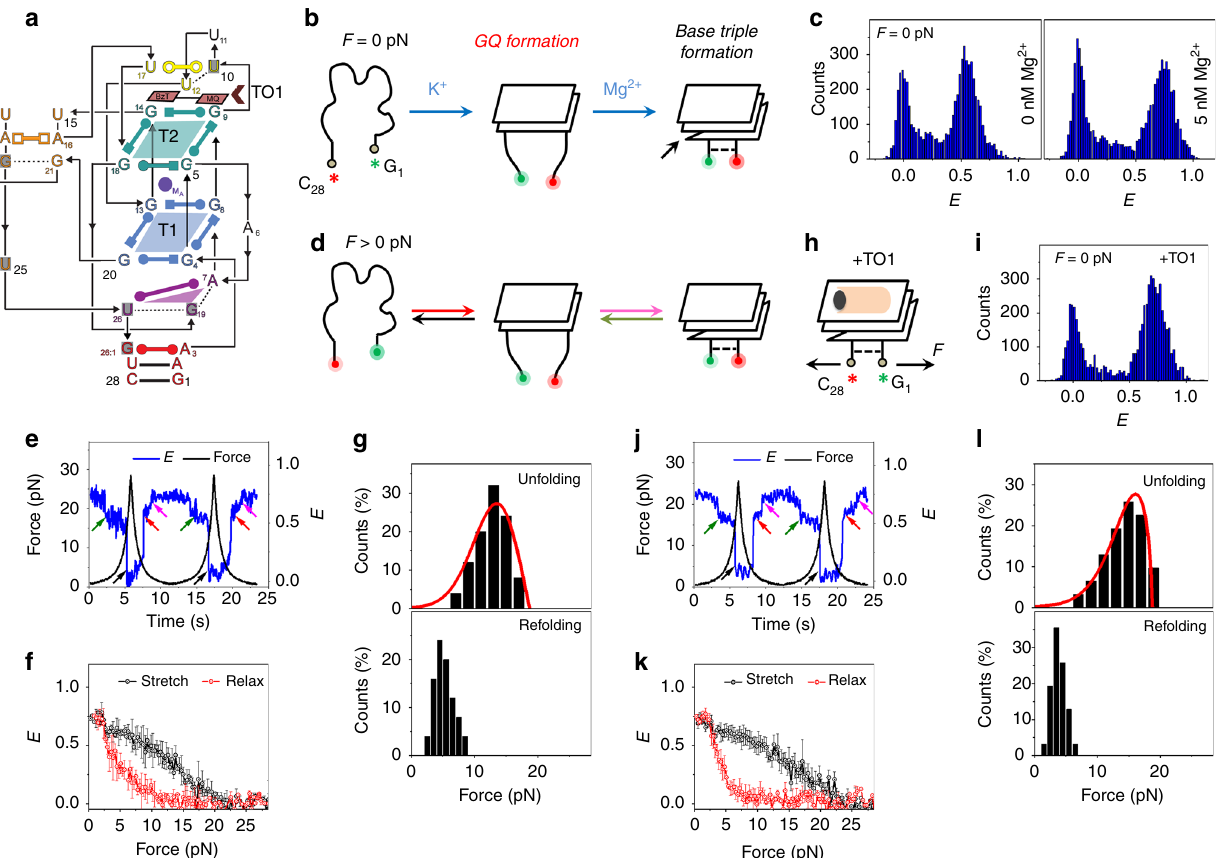
Fig. 3 Conformational dynamics of i MangoIII. a Sequence and secondary structure of i MangoIII used in this study. T1 and T2 denote the G-quartets in i MangoIII. TO1 is indicated by the brown arrowhead 51 . Adapted with permission from ref. 51 . b Schematic of probable sequential folding of i MangoIII GQ and the fl anking base triple, in the absence of force. The structures are drawn with reference to the recently solved crystal structure 51 . The Cy5 and Cy3 dyes adjacent to C 28 and G 1 are shown as red and green asterisks, respectively. c E histograms of i MangoIII in a buffer containing 100 mM K + , with (right) and without (left) Mg 2 + , in the absence of force. d Schematic of unfolding (green and black) and refolding (red and magenta) transitions of i MangoIII, under an applied force. Green and magenta arrows respectively indicate unfolding and refolding of the base triple. Black and red arrows indicate unfolding and refolding of the GQ core, respectively. e A representative smFRET time trajectory over two pulling cycles. Unfolding and refolding transitions at ~2.5 pN are indicated by green (stretch) and magenta (relax) arrows. The major unfolding and refolding transitions are shown via black and red arrows, respectively. f Average E vs force response. g Distributions of unfolding and refolding forces corresponding to the black and red arrows in d . ( N = 62 for both). The red curves represent force distributions estimated from the Dudko – Szabo model 46,47 (top). h A schematic of TO1- i MangoIII complex under tension. TO1 is represented by the orange and black symbol. Force ( F ) applied on the construct is shown by arrows. i E histogram of i MangoIII under saturated concentrations of TO1, in the absence of force. j A representative smFRET time trajectory of i MangoIII in the presence of TO1. The arrow indicators used are similar to e . k Average E vs force response in TO1 containing buffer. l Distributions of unfolding and refolding forces corresponding to the black and red transitions in i and fi ts (red curves) predicted from models proposed by Dudko et al. 46,47 ( N = 50 for both). Data presented in e – l were collected in a buffer containing 100 mM K + and 5 mM Mg 2 + . The time trajectories were acquired at an integration time of 20 ms. All error bars